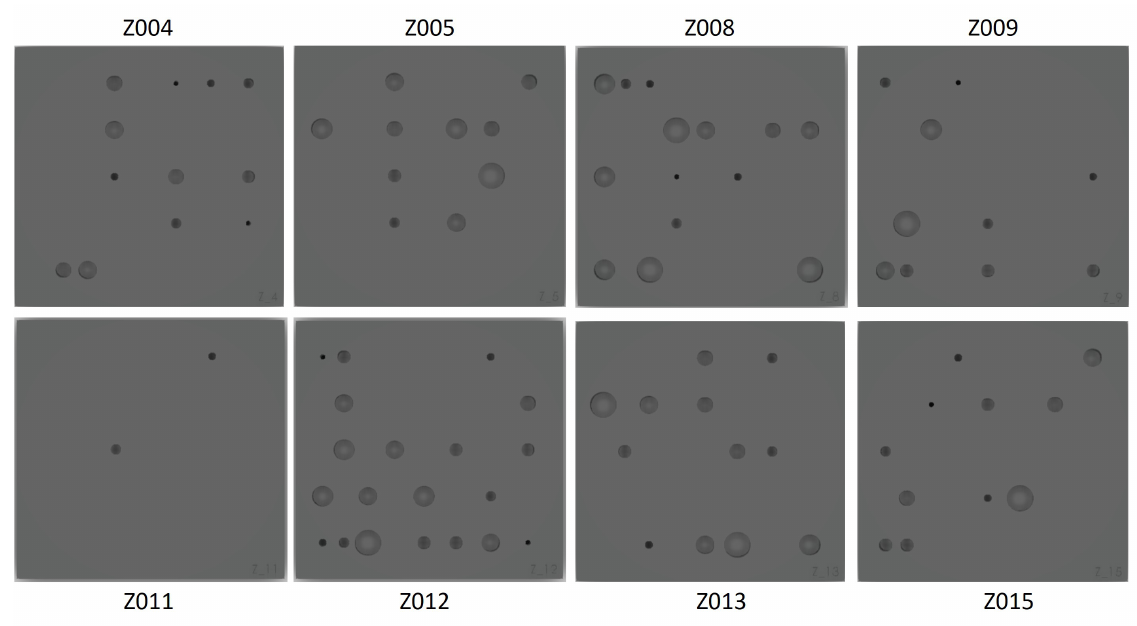
Figure 1. An example of specimens with defects in all possible sizes in all possible locations. The right part of the image shows all the possible depths of the defects, ranging from 2.5 mm to 4.5 mm from the right surface (bottom side).